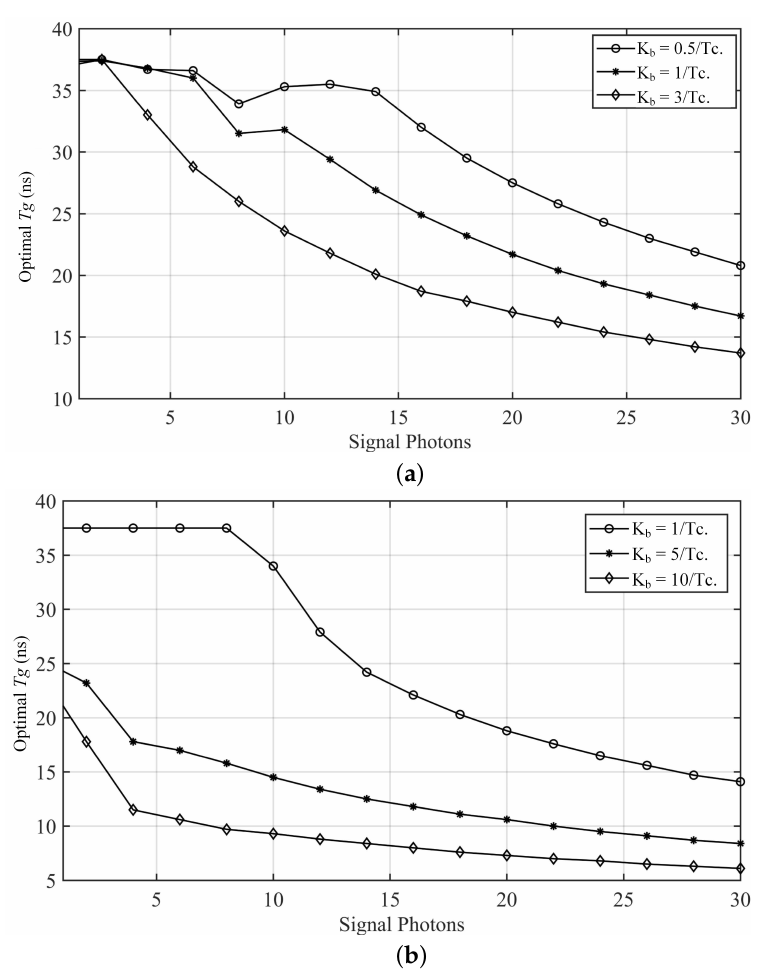
Figure 6. The optimal gate-ON time under different signal intensity. ( a ) N g = 16. ( b ) N g =